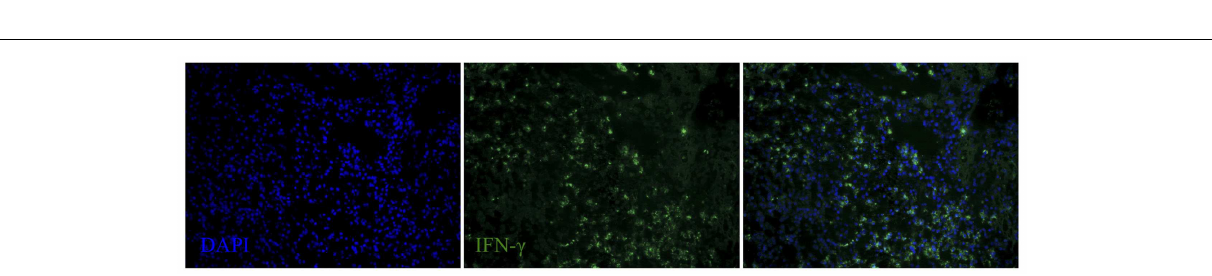
FIGURE 8 | IFN- γ expression in the spleen of a dolphin with hyperinsulinemia . Dolphin splenic tissue sections were incubated with primary anti-bovine IFN- γ , followed by nuclear staining usingVECTASHIELD mounting medium with DAPI. Original magnification 20 ×